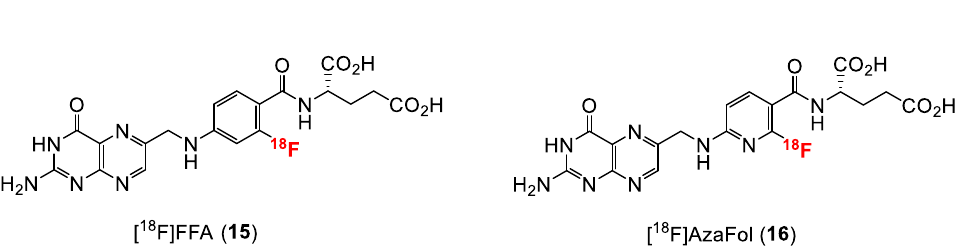
Figure 5. Structures of fluorine-18 labeled FA radiotracers prepared so far using integrated approach.